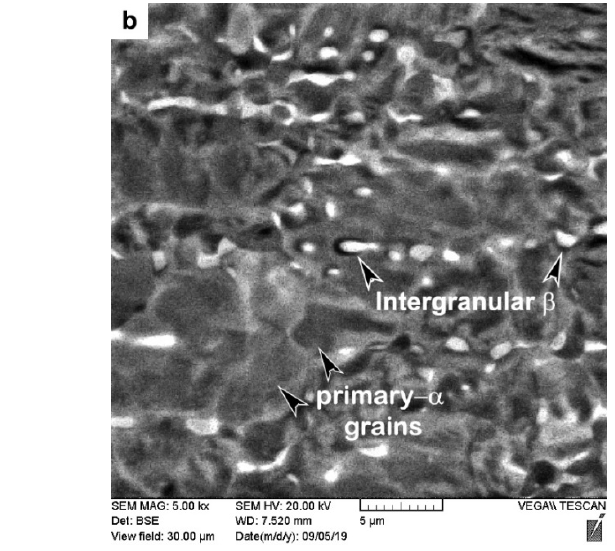
Figure 1. Bimodal microstructures of ( a ) Ti6242 and ( b ) Ti64 BMs. Workpieces for the LFW experiments were machined from the 25 mm thick Ti6242 and Ti64 plates to dimensions of 12.0 mm in depth (D) × 24.5 mm in width (W) × 33.0 mm in length (L) with a tolerance of 0.02 mm (Figure 2a). After machining, the contact surfaces of the Ti6242 and Ti64 workpieces were ground manually using 320-grit silicon carbide paper followed by rinsing with ethanol to remove surface contaminants and oxides just prior to clamping within the LFW fixtures. LFW of the dissimilar Ti6242 to Ti64 joints was conducted under standard ambient temperature (25 ◦ C) and pressure (101.325 kPa) conditions, without any shielding gas protection, using a MTS LFW process development system (PDS) (MTS Materials Test Systems, Eden Prairie, MN, USA) at the National Research Council Canada and a set of optimized welding parameters [40] that consisted of an oscillation frequency of 50 Hz, an oscillation amplitude of 2 mm, friction and forging pressures of 90 MPa, a shortening of 2 mm and a total welding time of ~1.3 s. Subsequently, SRA of the dissimilar Ti6242–Ti64 linear friction welds was performed at a temperature of 750 ◦ C and a pressure of 1.6 × 10 − 2 Pa for 2 h in a ceramic-tube vacuum-furnace. Using electro-discharge machining (EDM) (Fanuc, Oakville, ON, Canada), specimens were extracted, as shown in Figure 2b, for metallographic, tensile and fatigue testing of the dissimilar Ti6242–Ti64 linear friction welds. Metallographic preparation of the dissimilar Ti6242–Ti64 welded specimens involved hot mounting in a conductive resin followed by automated grinding and polishing to a surface finish of 0.02 µ m, as described in [39]. Etching for 6–12 s with Kroll’s reagent (100 mL of distilled water, 6 mL of nitric acid (HNO 3 ) and 2 mL of hydrofluoric acid (HF)) was used to reveal the characteristics of the different microstructural features (phase constituents, morphology, grain structure, etc.) for microscopic examination using optical microscopy (OM) (Olympus, Richmond Hill, ON, Canada) and scanning electron microscopy (SEM) (Tescan, Warrendale, PA, USA) at 20